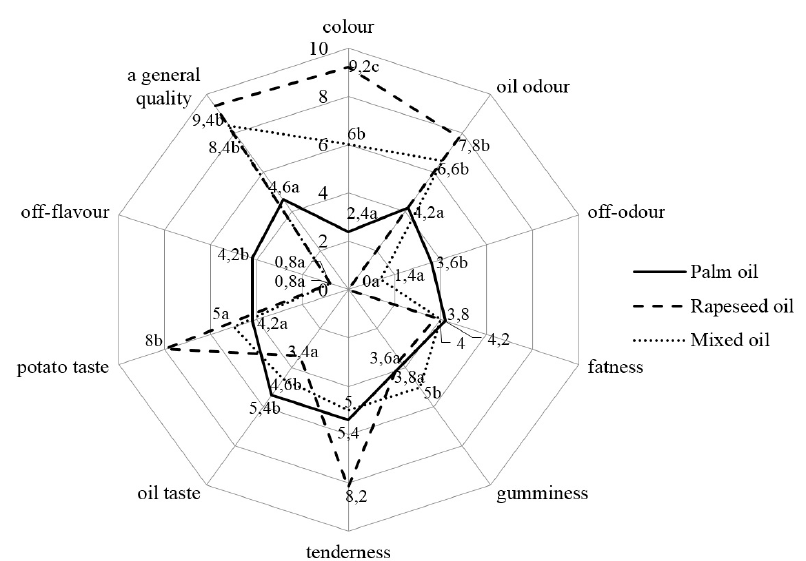
Fig. 5: Organoleptic characteristics of French fries fried in palm oil, rapeseed oil and mixed